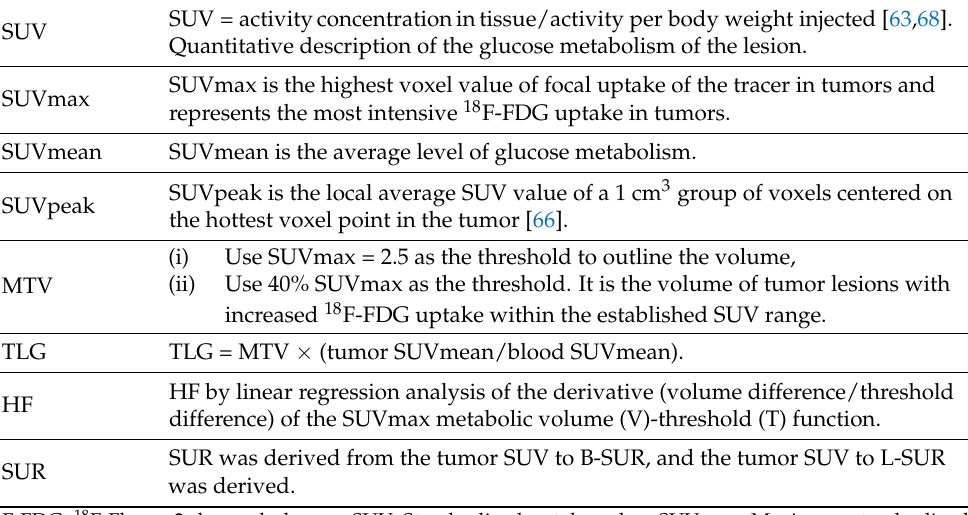
Table 1. Comparison of the calculation of different 18 F-FDG PET/CT parameters. SUV = activityconcentrationintissue/activity per body weight injected [63,68]. SUV Quantitative description of the glucose metabolism of the